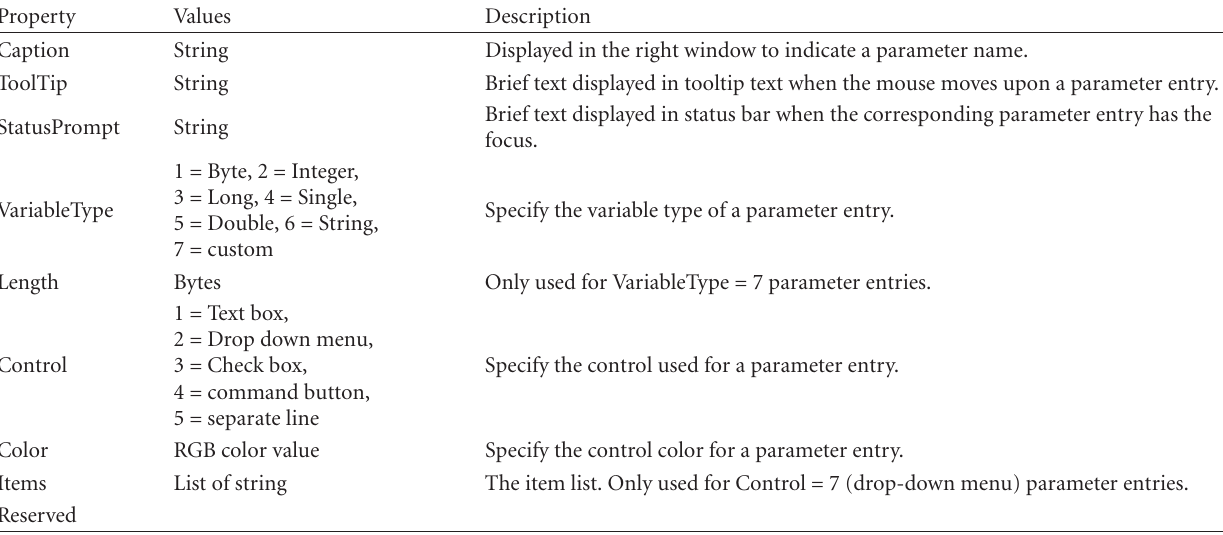
Table 3: Properties of parameter entries that can be customized in “PlsFdCfg.ini” file.